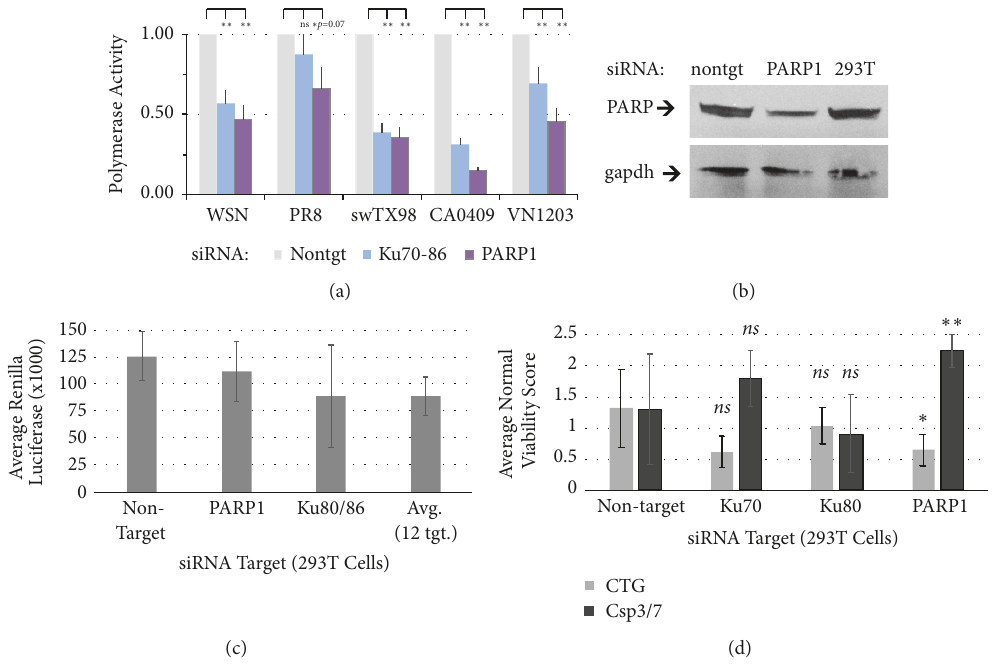
Figure 1: PARP1 is required for optimal activity of the influenza A virus RNA-dependent RNA polymerase. (a) Host factors are required for influenza A virus polymerase function. For minigenome reporter assays, cDNA encoding influenza polymerase proteins (PB1, PB2, PA, and NP), a firefly luciferase reporter driven by a virus RdRP-binding site promoter, and a constitutive Renilla luciferase internal reference were transfected into human HEK 293T cells targeted with siRNA against human PARP1, Ku70, and Ku80/86 (Ku70-86), or scrambled siRNA control (Nontgt), in duplicate. Polymerases from influenza A virus strains included human A/WSN/33 (H1N1) (WSN) , human A/PR/8/34 (H1N1) (PR8) , A/swine/Texas/4199-2/98 (H3N2) (swTX98) , human A/California/04/09 (pdmH1N1) (CA0409) , or avian-derived A/Viet Nam/1203/04 (H5N1) (VN1203) . Polymerase activity of the negative control was normalized for each strain to 1.0. (b) Immunoblot showing PARP1 protein depletion with GAPDH protein as internal reference. Cellular RNA polymerase II-mediated expression of plasmid encoding Renilla luciferase(c)and(d)cellviabilityassaysmeasuringATPavailability(CellTiter-Glo, CTG )andapoptosisbycaspaseactivation( Csp3/7 ), in 293T cells targeted with siRNA. Significance estimated by 2-tailed t-test, with p values p < 0.05 ( ∗∗ ) or p < 0.1 ( ∗ )